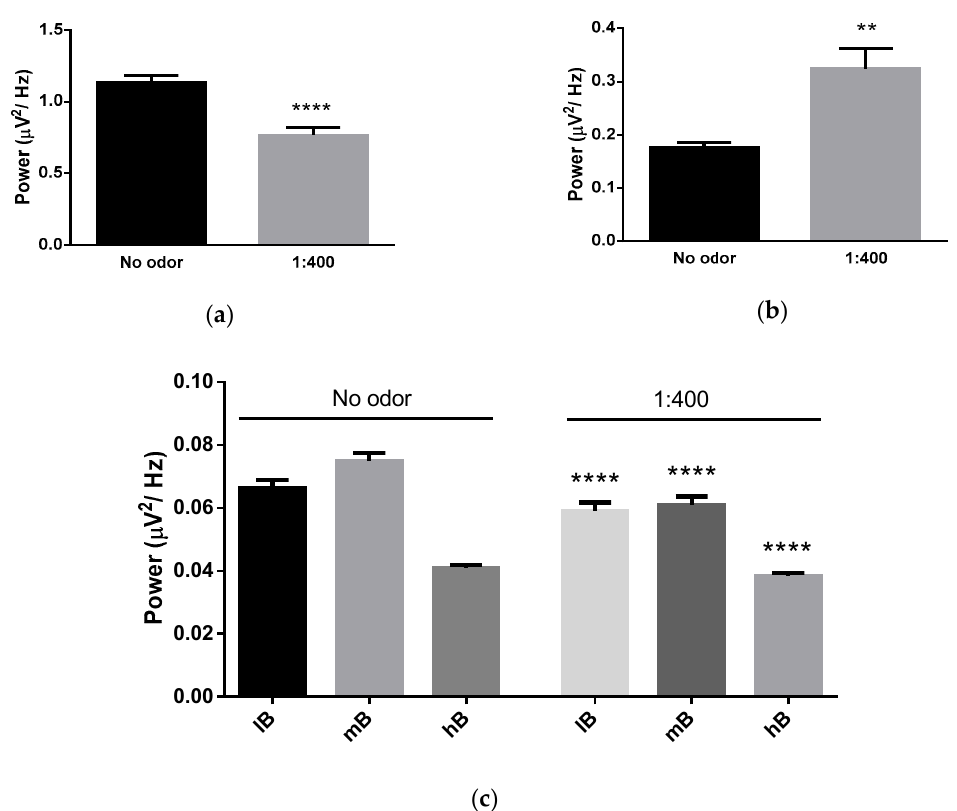
Figure 2. Power spectral analysis of human brainwave during linalool inhalation characterized by frequencies consisting of slow alpha, fast alpha, low beta, mid beta, and high beta in female subjects. ( a ) Slow alpha wave activities during 1:400 diluted linalool inhalation compared with absence of the odor. ( b ) Fast alpha wave activities during absence and presence of the odor. ( c ) Low, mid, and high beta wave activities during presence and absence of the odor. lB, mB, and hB represent low beta, mid beta, and high beta, respectively. ** and **** represent p < 0.01 and p < 0.0001, respectively.